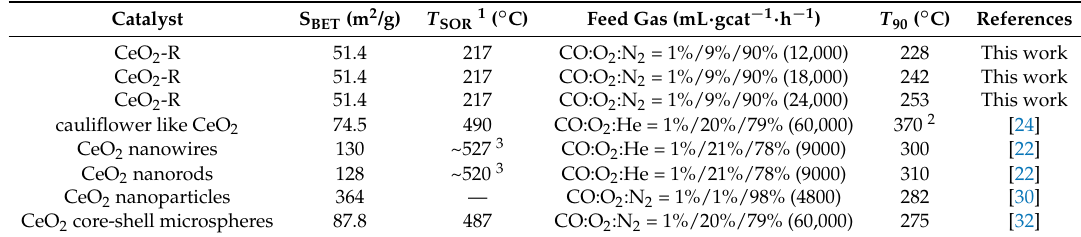
Table 3. Comparison of different CeO 2 catalysts for CO